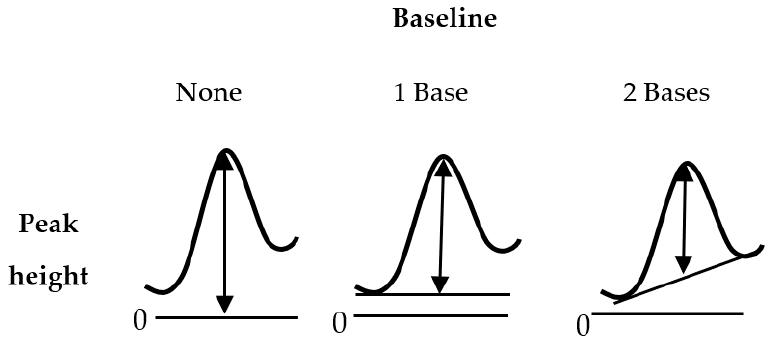
Figure 6. Different baselines that might be used to determine peak height (absorbance) [35]. Figure 6. Di ff erent baselines that might be used to determine peak height (absorbance)